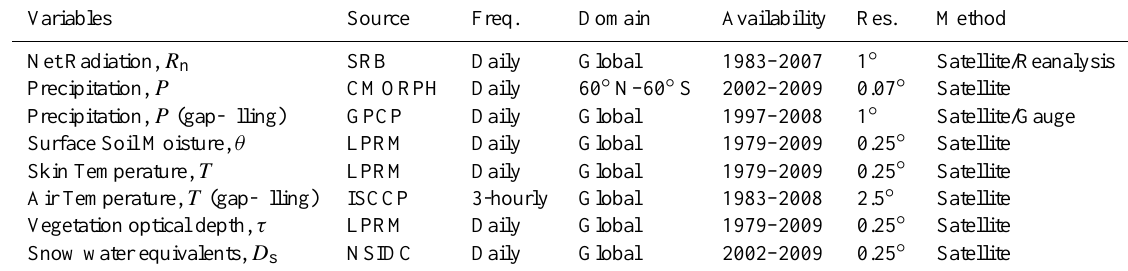
Table 1. Remotely-sensed data sets used for computing GLEAM E estimates (see Sect. 3 for explanation of abbreviations). Variables Source Freq. Domain Res. Net Radiation, R n SRB Daily Precipitation, P